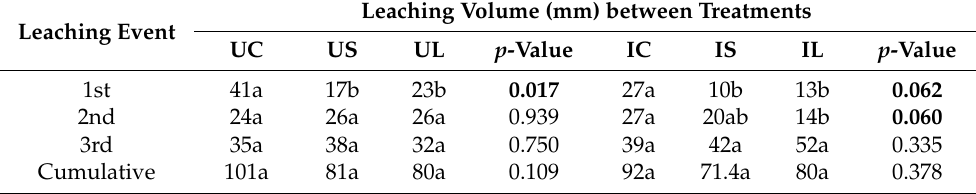
Table 4. Treatment effects on the amount of drainage collected for every leaching event including cumulative drainage volumes.